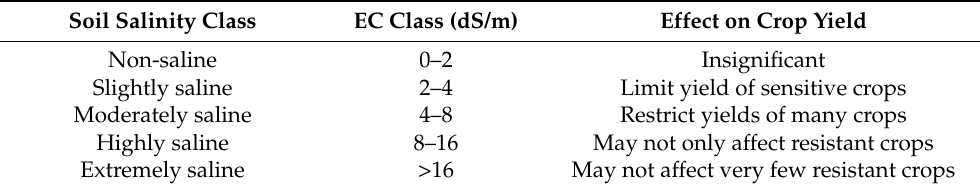
Table 2. Soil salinity classes with soil EC values and potential effects on crop